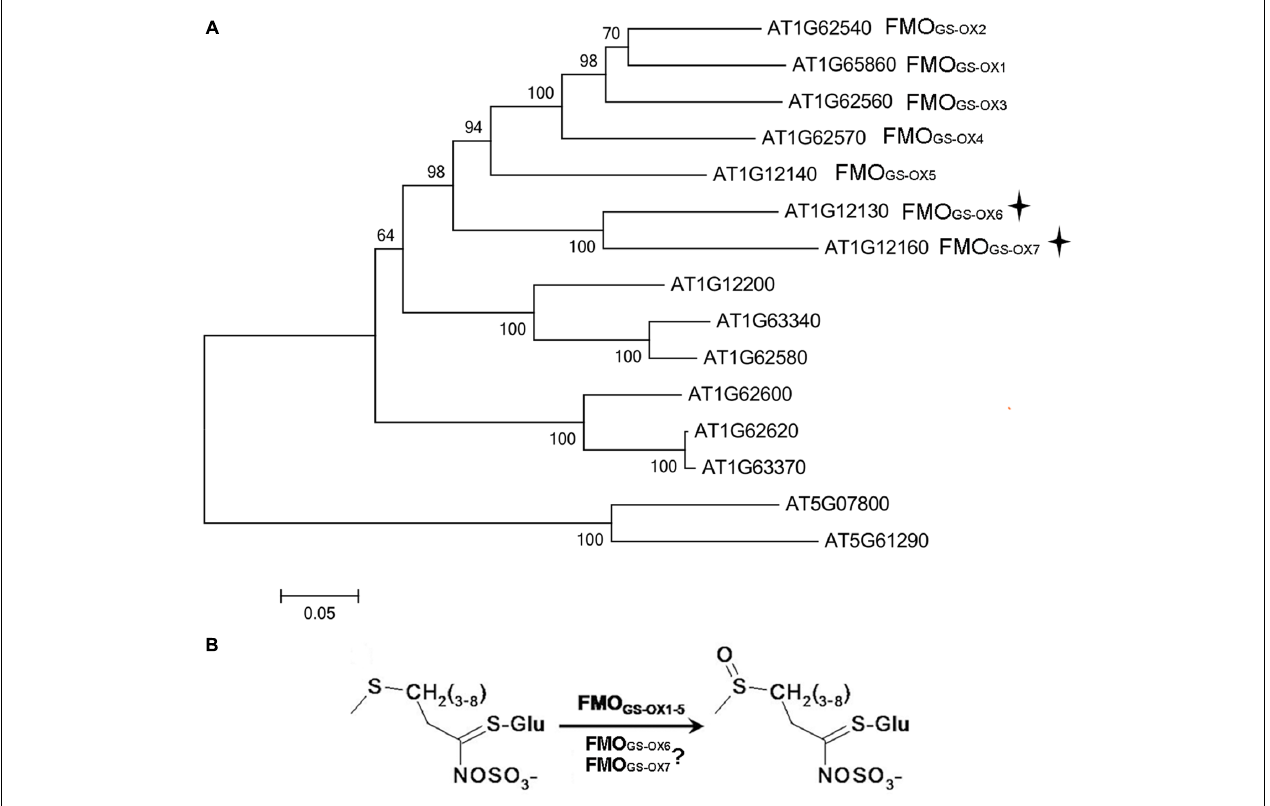
FIGURE 1 | (A) Phylogenetic tree of Arabidopsis flavin-containing monooxygenases (FMOs) possessing the conserved GS-OX domains. (B) FMO GS - OX6 and FMO GS - OX7 are predicted to catalyze S -oxygenation of methylthioalkyl (MT) Glucosinolates (GSLs) to methylsulfinylalkyl (MS) GSLs.